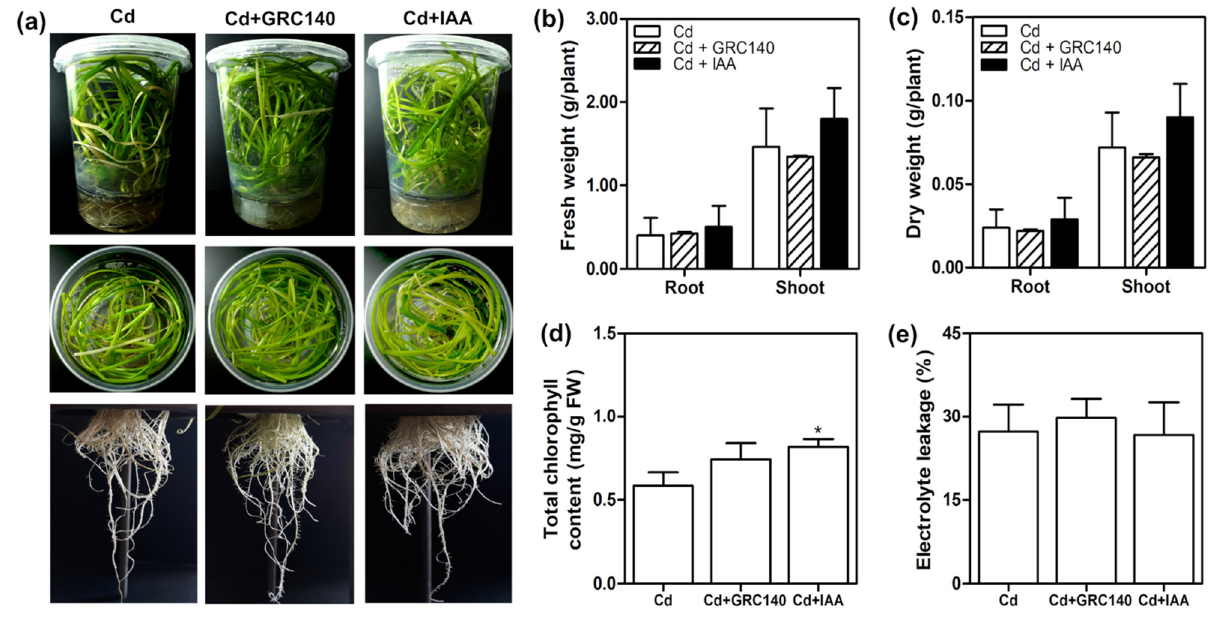
Figure 4. Effect of P. rhodesiae GRC140 and IAA on T. latifolia exposed to Cd. Sixty-day-old T. latifolia plants were treated with IAA (1.0 µ M) or inoculated with P. rhodesiae GRC140 (10 6 CFU/mL) for 6 days and exposed to 40 mg/L of Cd for ten days. ( a ) Shoot and root phenotype appearance, ( b ) fresh weight, ( c ) dry weight, ( d ) total chlorophyll content, ( e ) root electrolyte leakage. The values represent the mean ± SD ( n = 3). Asterisks indicate significant differences between control (Cd) and treatment (Dunnett’s test; * p < 0.05).